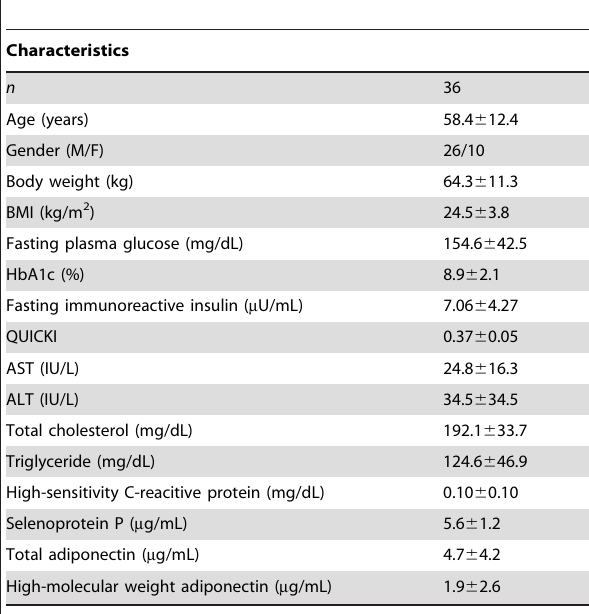
Table 1. Clinical and laboratory